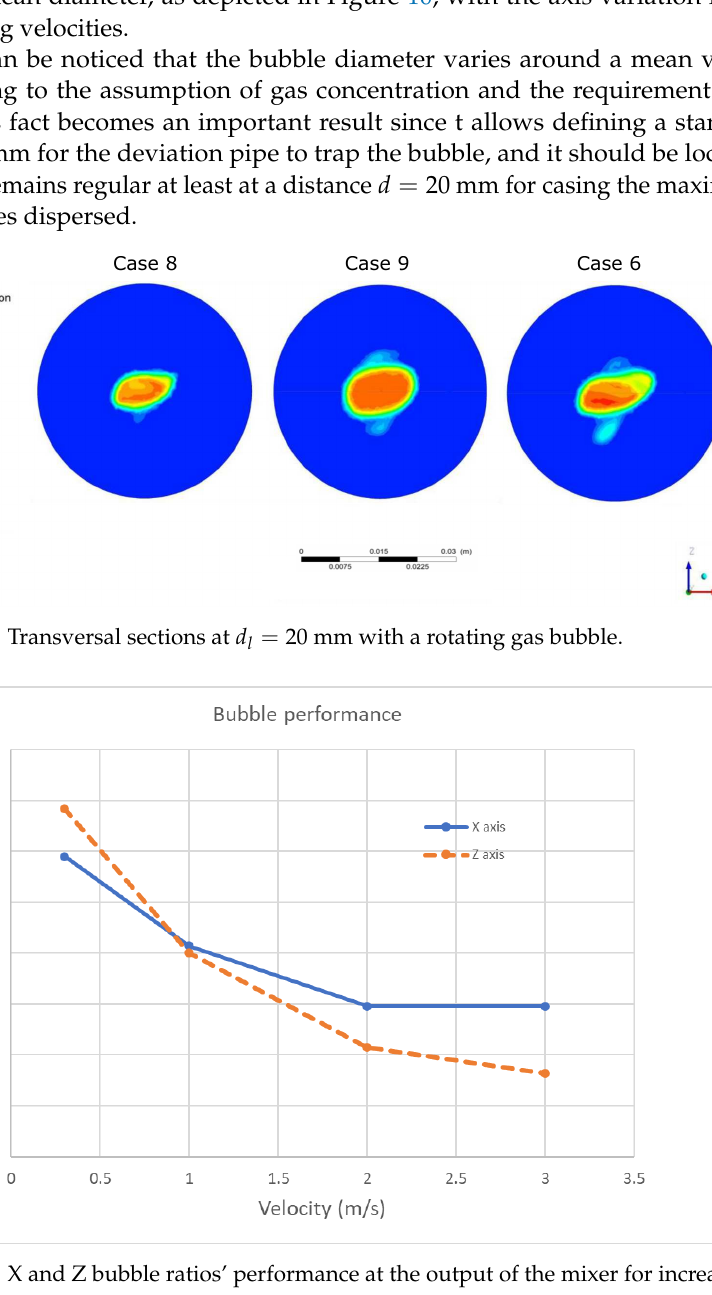
Figure 11. X and Z bubble ratios’ performance at the output of the mixer for increasing